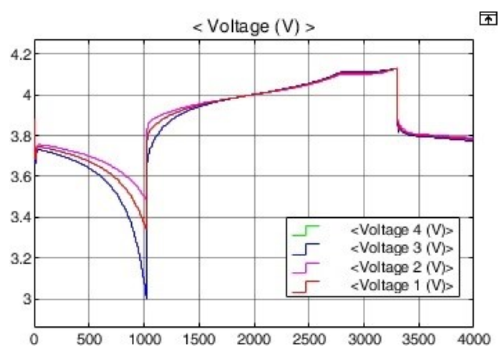
Figure 12. Simulation applying the proposed cell-balancing